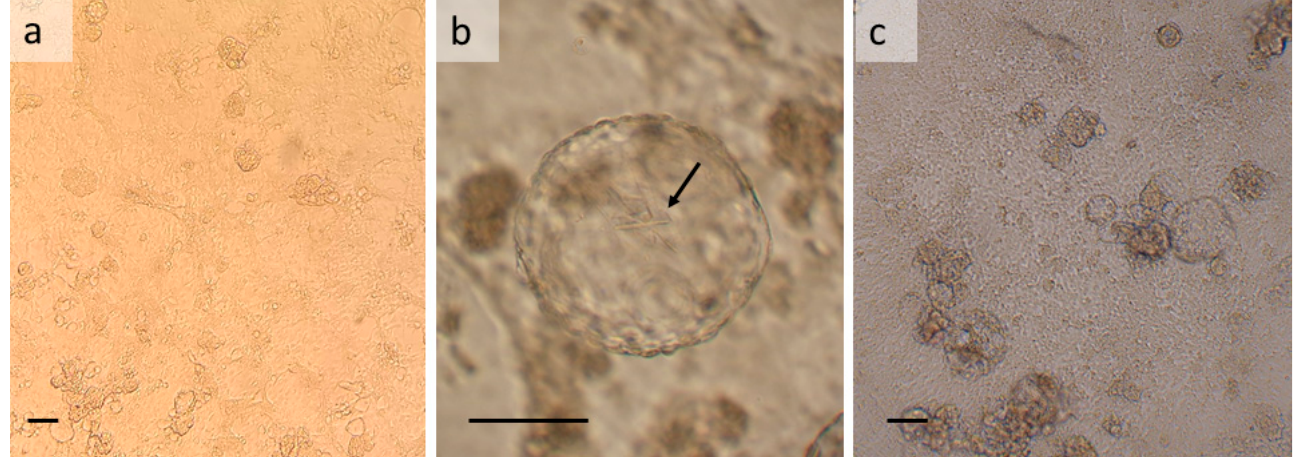
Figure 2. Rhodnius prolixus embryo-derived cell lines RPE/LULS53 and RPE/LULS57. ( a ) General view of RPE/LULS53 at passage 8; ( b ) needle-shaped and rectangular crystals inside a RPE/LULS53 multicellular vesicle at passage 15; ( c ) general view of RPE/LULS57 cells at passage 12. Live, inverted microscope; scale bars 100 µm.